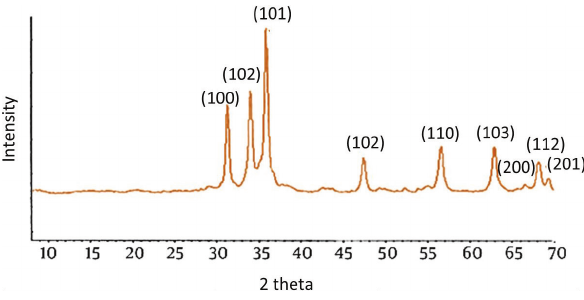
Figure 3: XRD pattern of biosynthesized zinc oxide